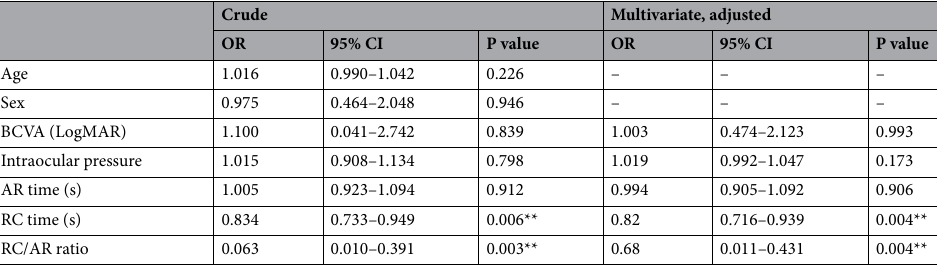
Table 3. Factors which reflect the differences of retinal diseases and choroidal diseases. Logistic regression analyses. In the multivariable analysis, potential factors were adjusted for age and sex. AR time arm-to-retina